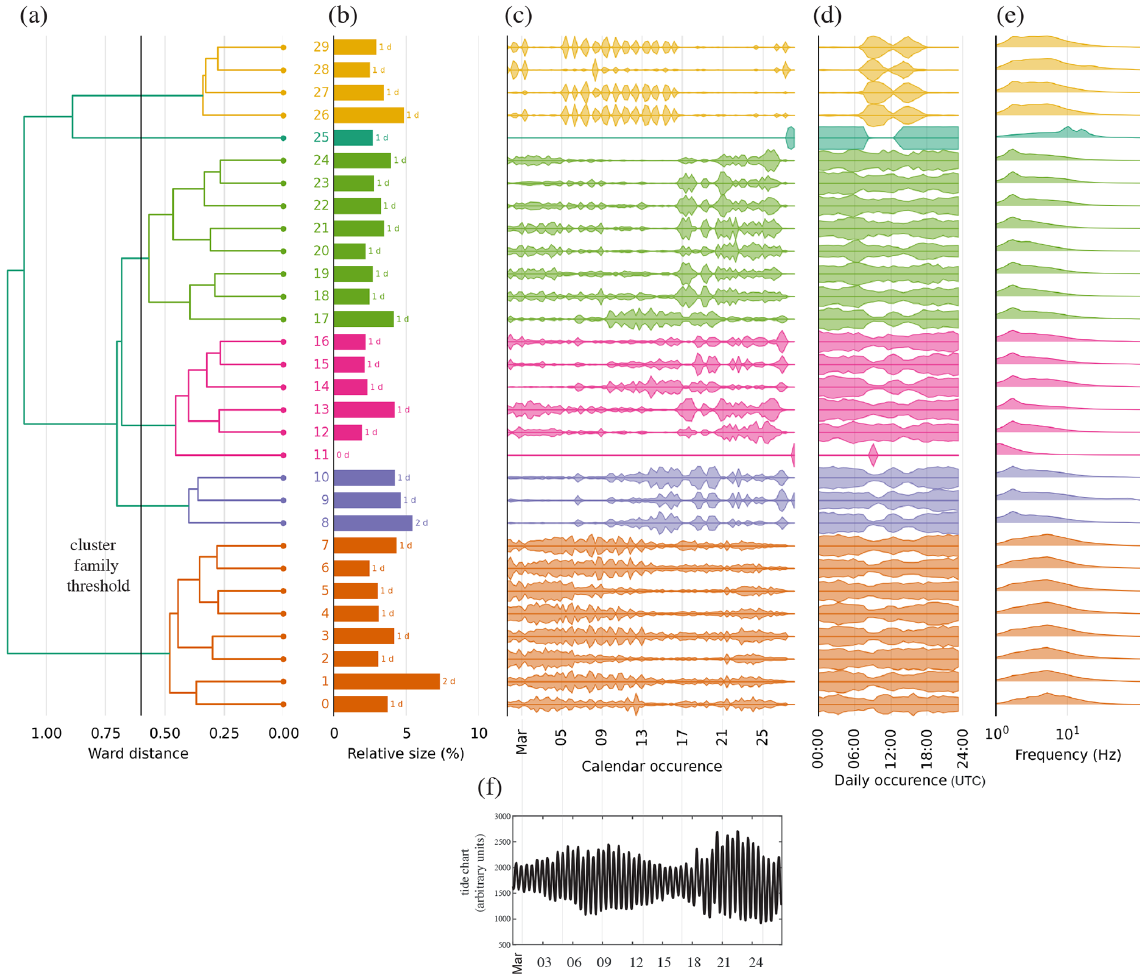
Figure 3. (a) Hierarchical representation of the ambient seismic field after the scatseisnet algorithm was applied to the 27d of contin- uous recording at station S 1 . A total of 6 families (shown as different colors) and 30 clusters are categorized. For each sub-family: (b) cumu- lated duration of the waveforms, (c) calendar occurrence, (d) time of day of occurrences and (e) spectrum of the waveforms. (f) Tide chart at the Ny-Ålesund station ( ∼ 160km away from Lake